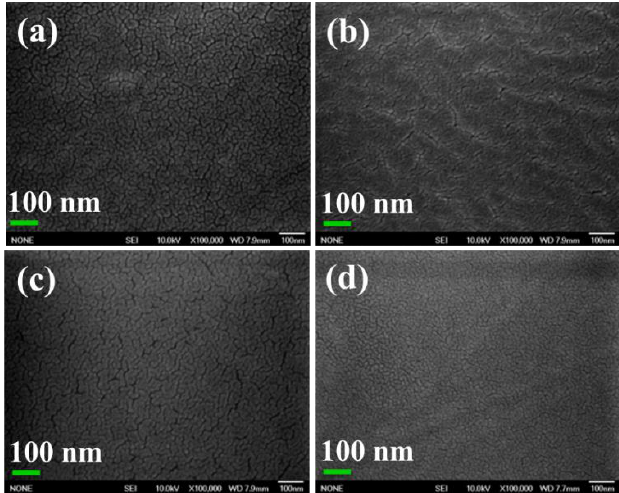
Figure 3. FE-SEM images of membranes of ( a ) X;( b ) XY; ( c ) XYX; and ( d ) YXY.